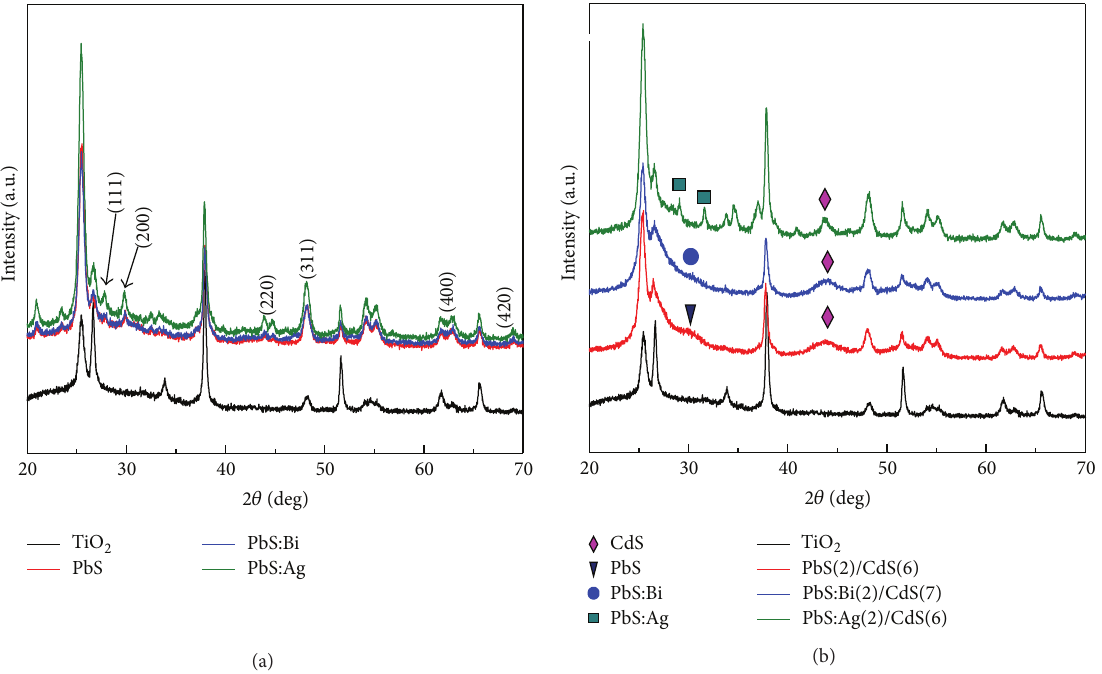
Figure 2: XRD patterns of TiO 2 , Bi-doped-PbS, Ag-doped-PbS, Bi-doped-PbS/CdS, and